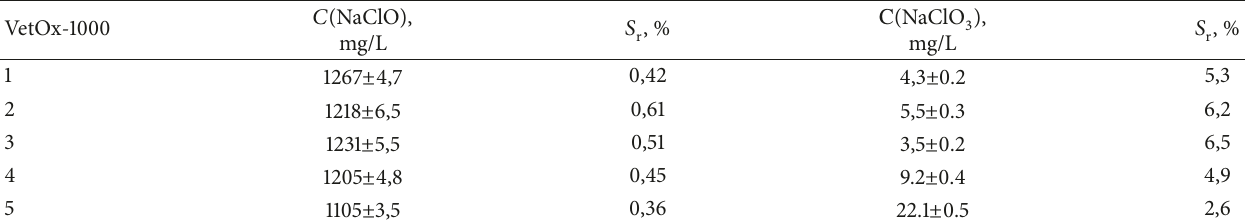
Table 5: The results of the determination of sodium hypochlorite and sodium chlorate in VetOx-1000 (N = 5, P =